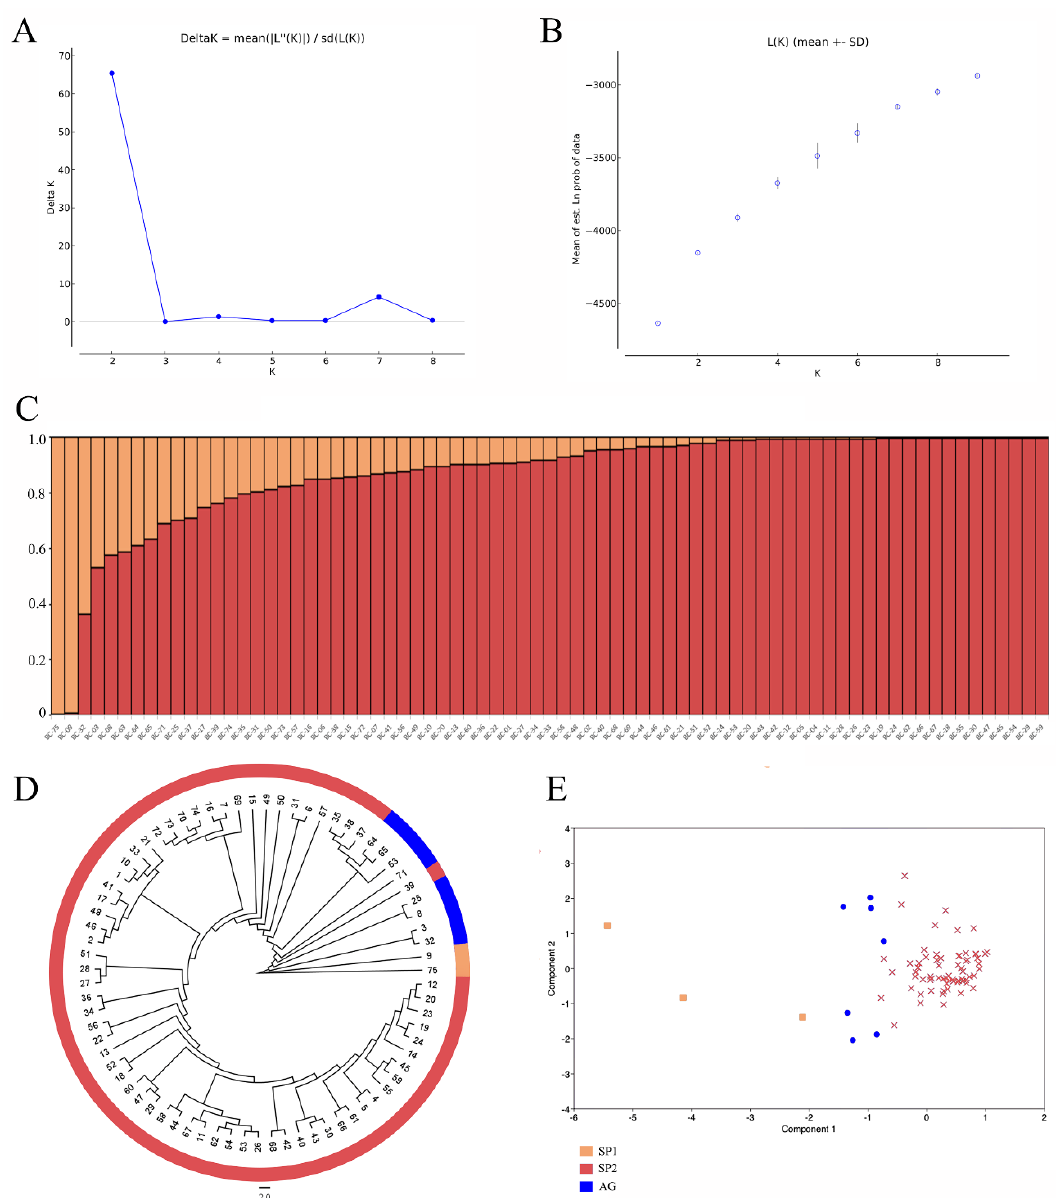
Figure 1. Population structure analysis and PCA of the 75 Ethiopian mustard accessions. ( A ) Estimation of the optimum number of groups (K). ( B ) Graph for the parameter L(K) and number of K. ( C ) Population structure at K = 2. ( D ) Cluster analysis of the 75 Ethiopian mustard accessions. Numerical values 1 – 75 represent accessions BC01 – BC75. ( E ) PCA of the 75 Ethiopian mustard accessions.